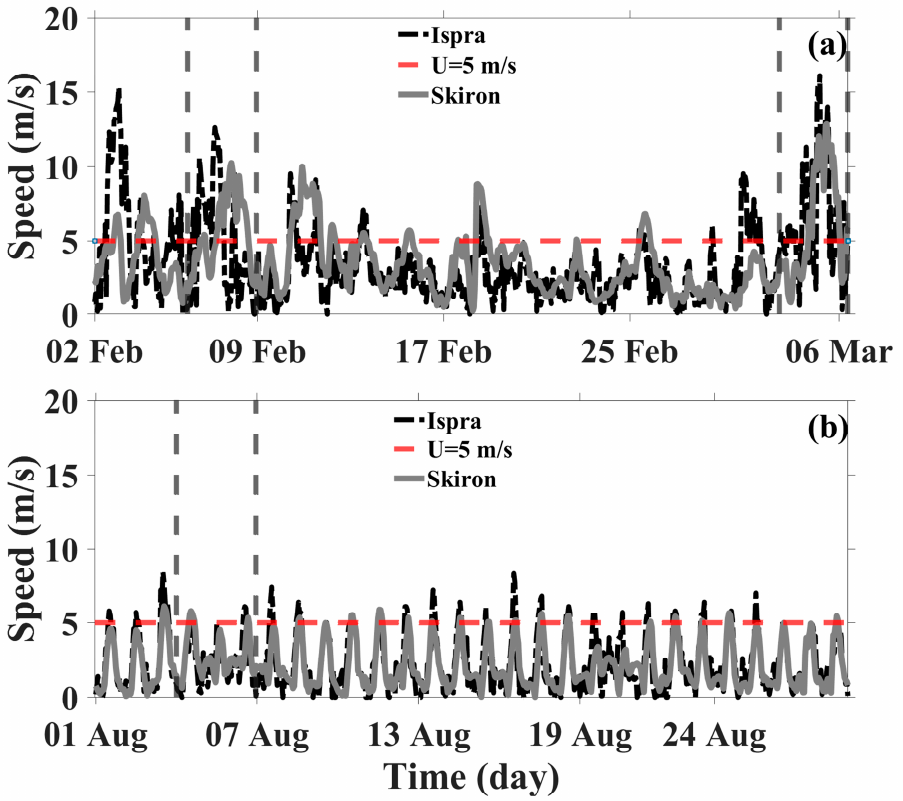
Figure 2. Time series of wind speed (m/s) observed by the ISPRA weather station (dash-and-dot black line) and simulated by the SKIRON/Eta model (solid grey line) for the winter (upper) and summer (lower) periods. The red dashed line identifies the threshold value of wind speed set at 5 m/s (see text). The grey dashed vertical lines show the periods analyzed: ( a ) from 00:00 of 6 February to 23:00 of 8 February; from 10:00 of 3 March to 09:00 of 6 March; ( b ) from 00:00 of 4 August to 23:00 August.